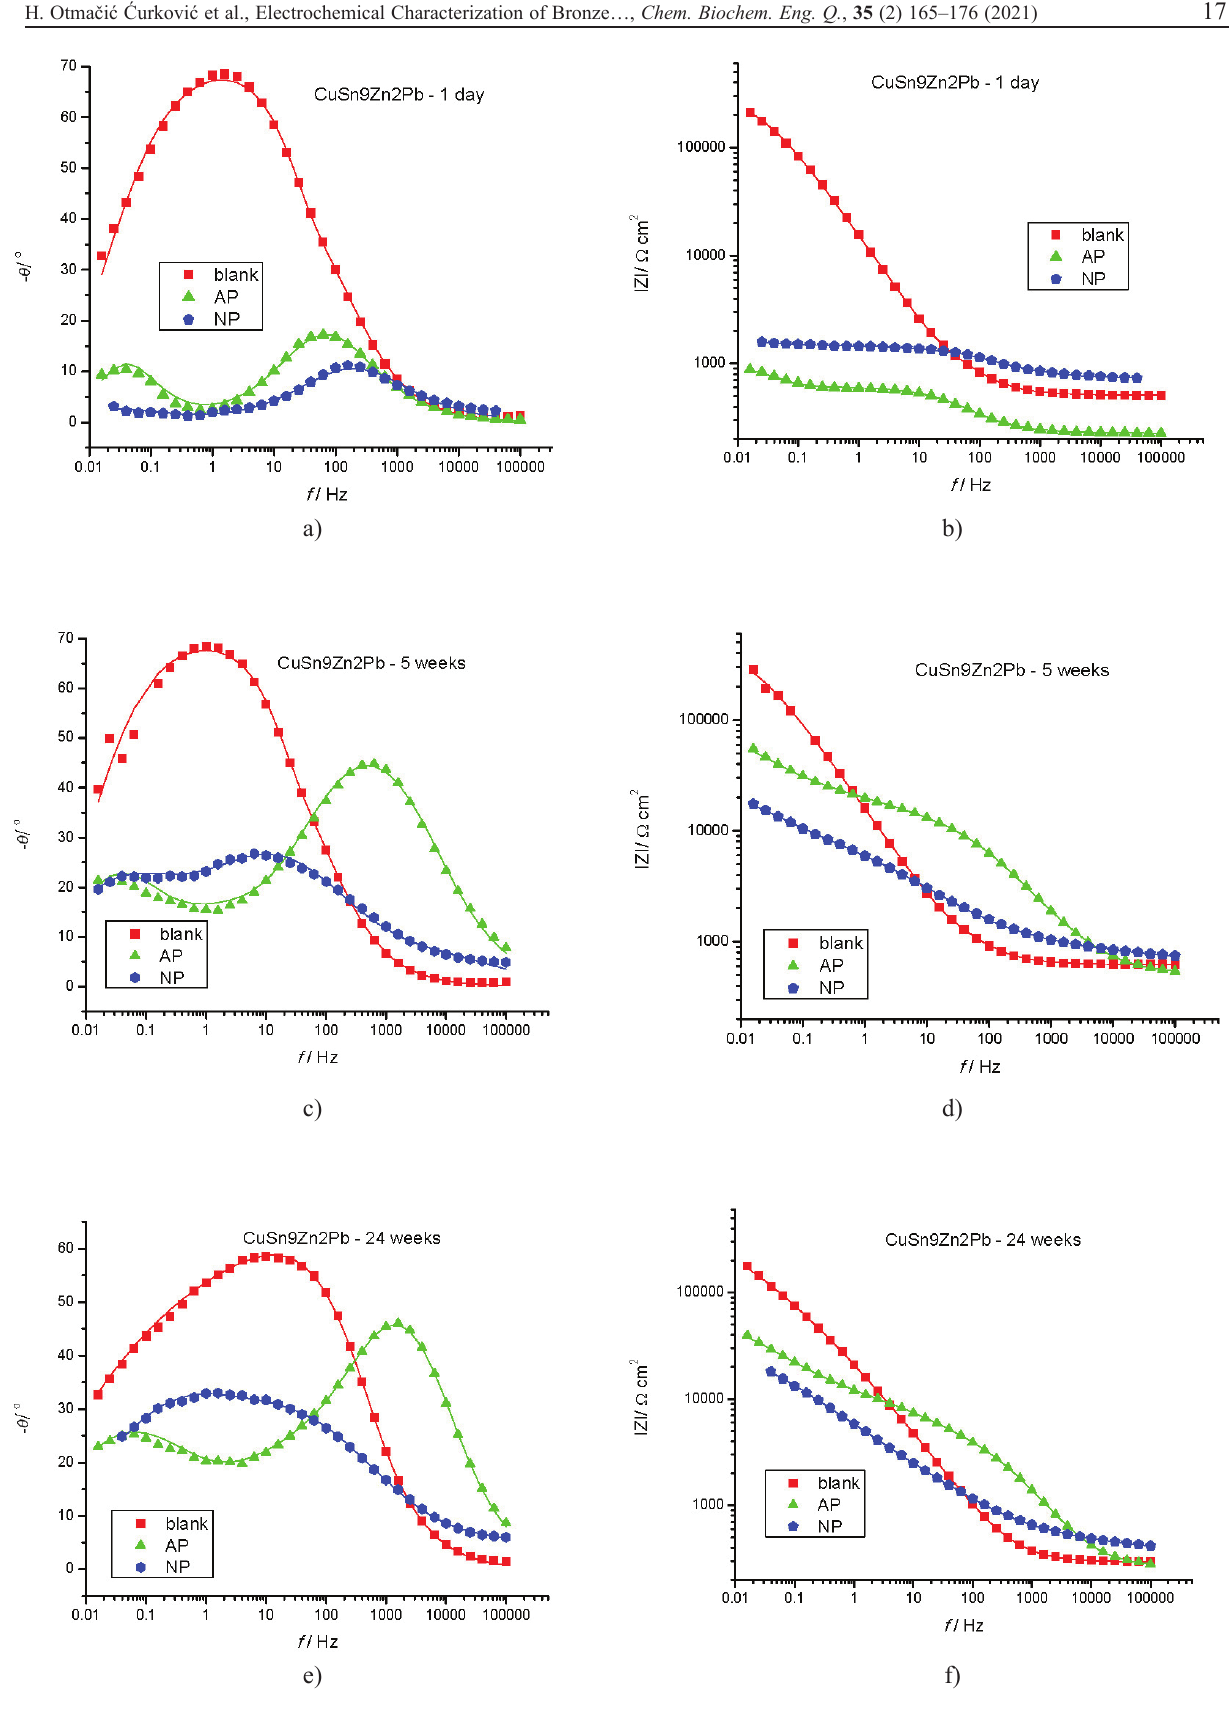
Fig. 4 – Bode impedance plots for blank and patinated CuSn9Zn2Pb samples collected after different periods of exposure to out- door